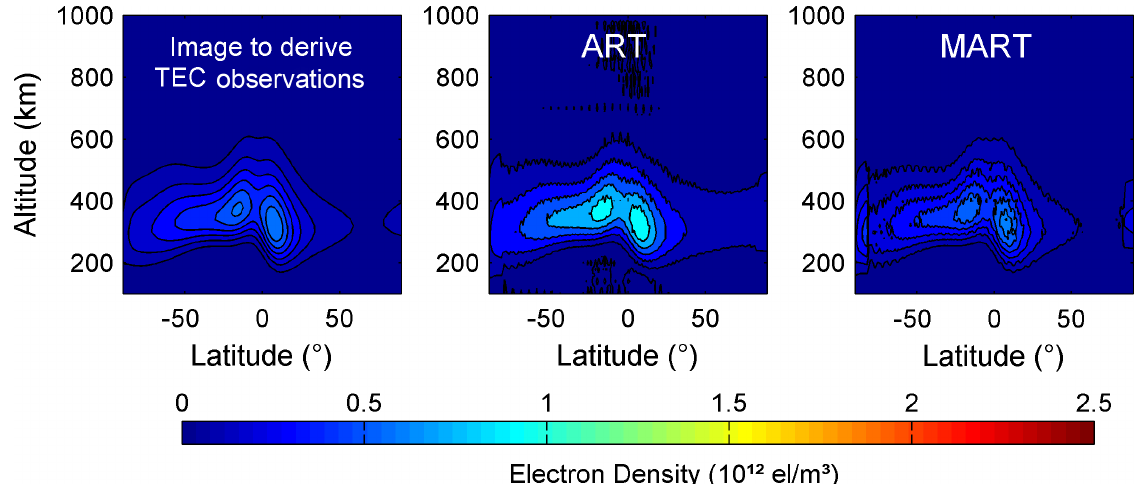
Figure 4 - 2D algebraic technique performance in Case II (smaller electron density values).